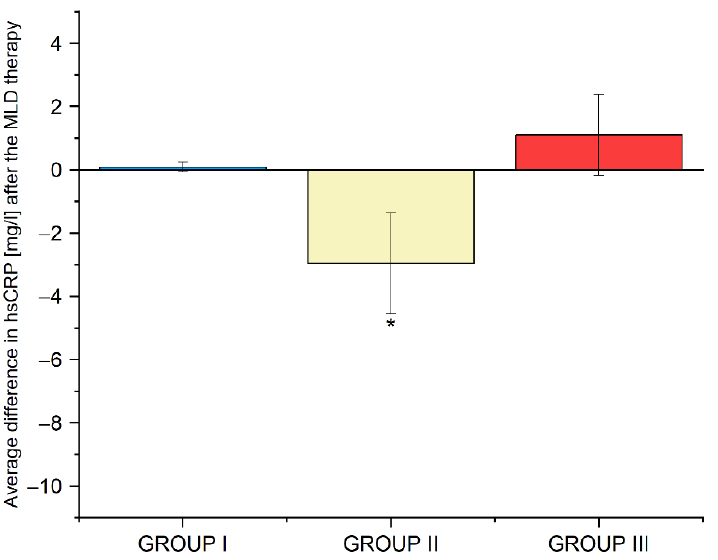
Figure 3. Average differences in hsCRP levels in groups I, II and III before and after the use of MLD